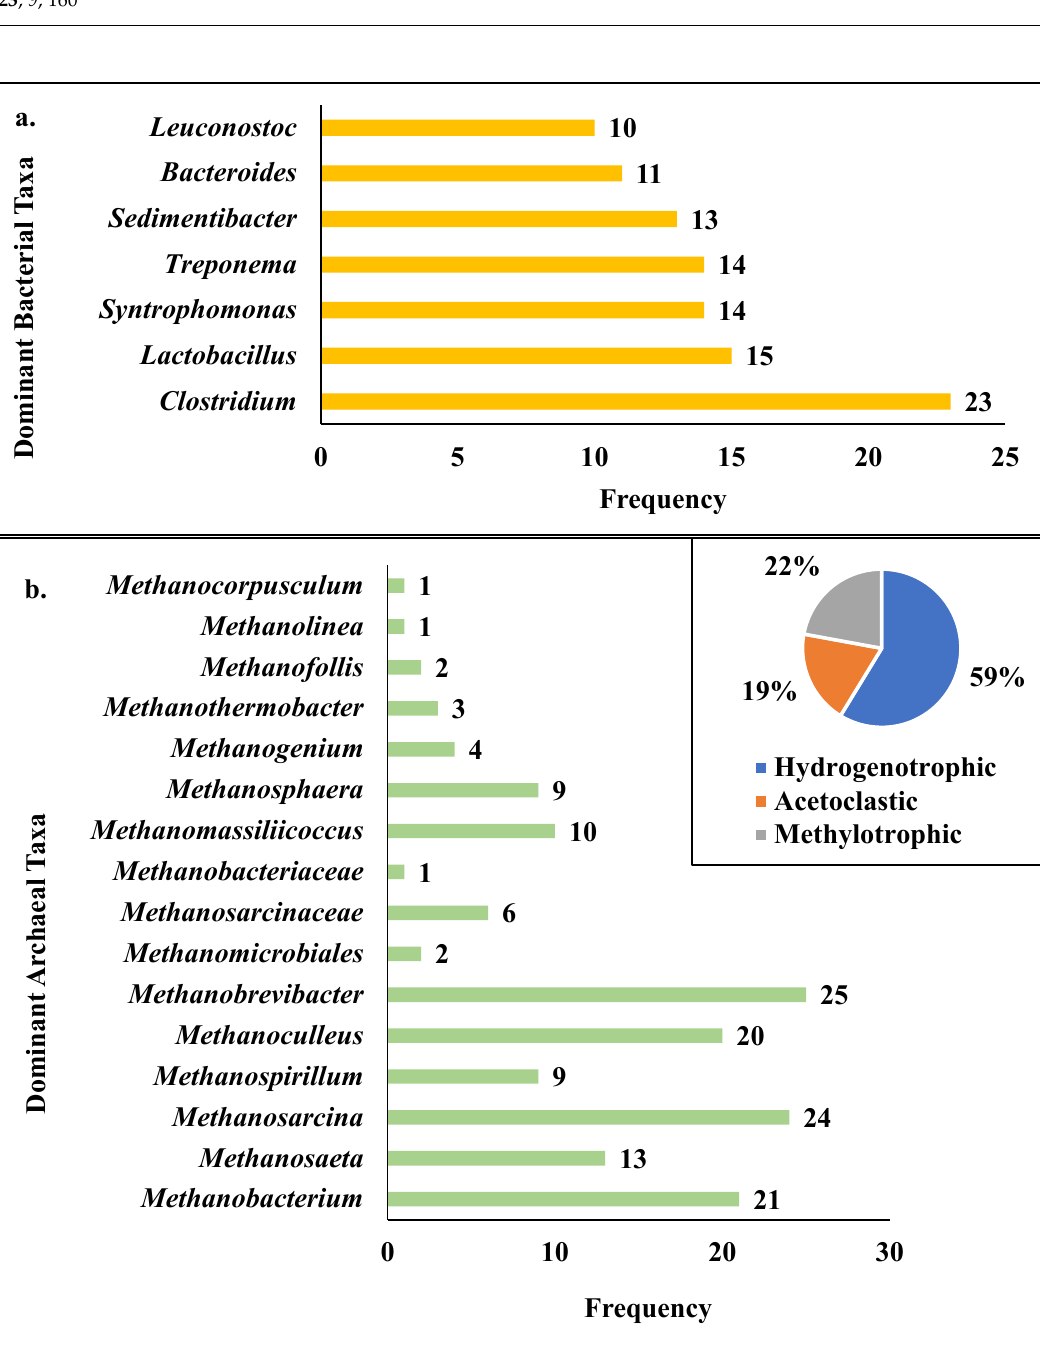
Figure 2. ( a ) Frequency of bacterial taxa (occurring > 2% of total) and ( b ) archaeal taxa in digestate communities reported in Table 1. The inset figure represents the percentage of taxa within these communities that play a role in hydrogenotrophic, acetoclastic or methylotrophic methanogenesis.